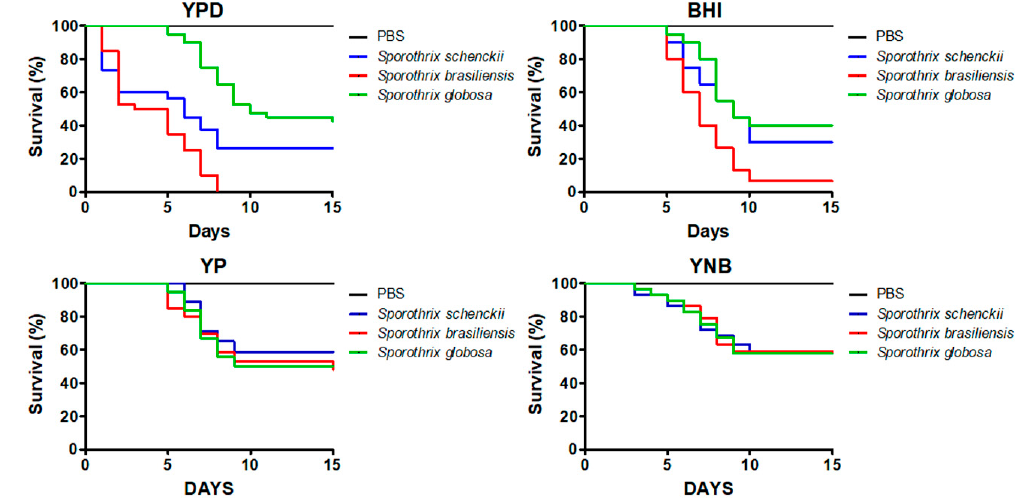
Figure 1. Mortality curves of Galleria mellonella larvae infected with Sporothrix schenckii , Sporothrix brasiliensis, or Sporothrix globosa . The yeast-like cells were grown in yeast–peptone–dextrose (YPD), brain–heart infusion (BHI), YP, or YNB media and were used to inoculate 1 × 10 5 yeast-like cells per animal. Each group contained 30 larvae (10 larvae for each experiment). Larvae were monitored daily to assess survival, which was defined by the presence of irritability and the absence of extensive body melanization. PBS, control group injected only with PBS.